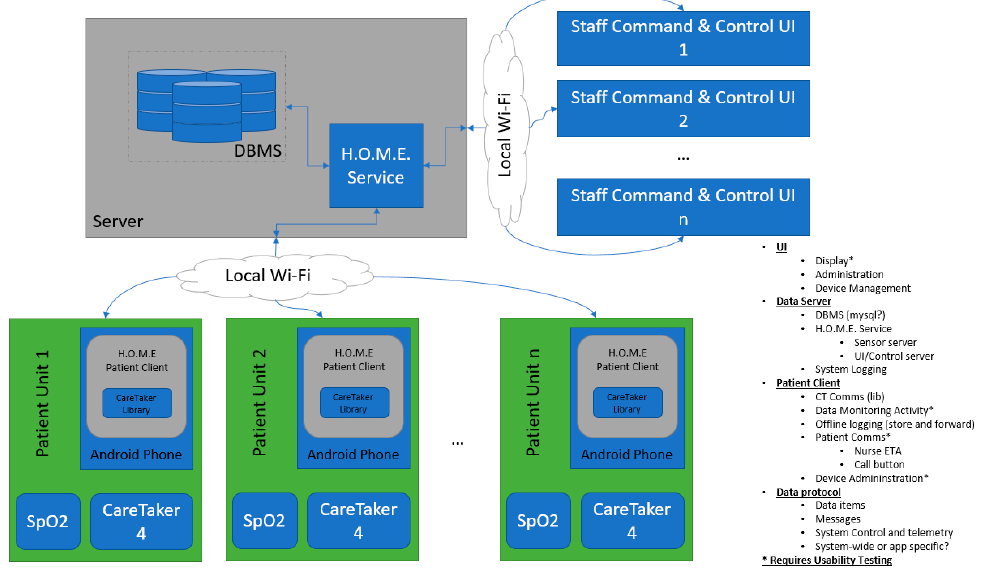
Figure 4. Proposed system architecture.